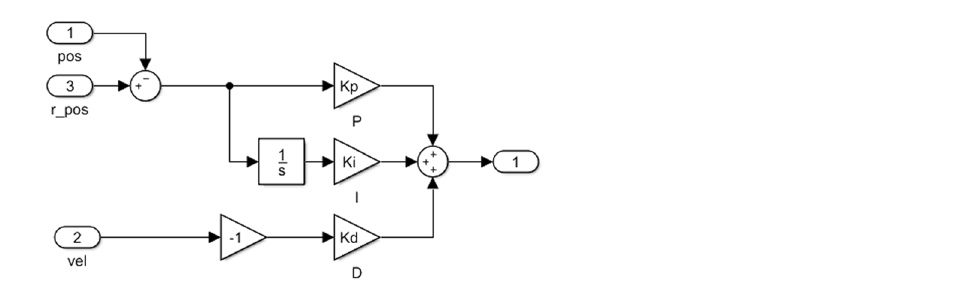
Figure 5. Diagram of PID controller Simulink of wave compensation